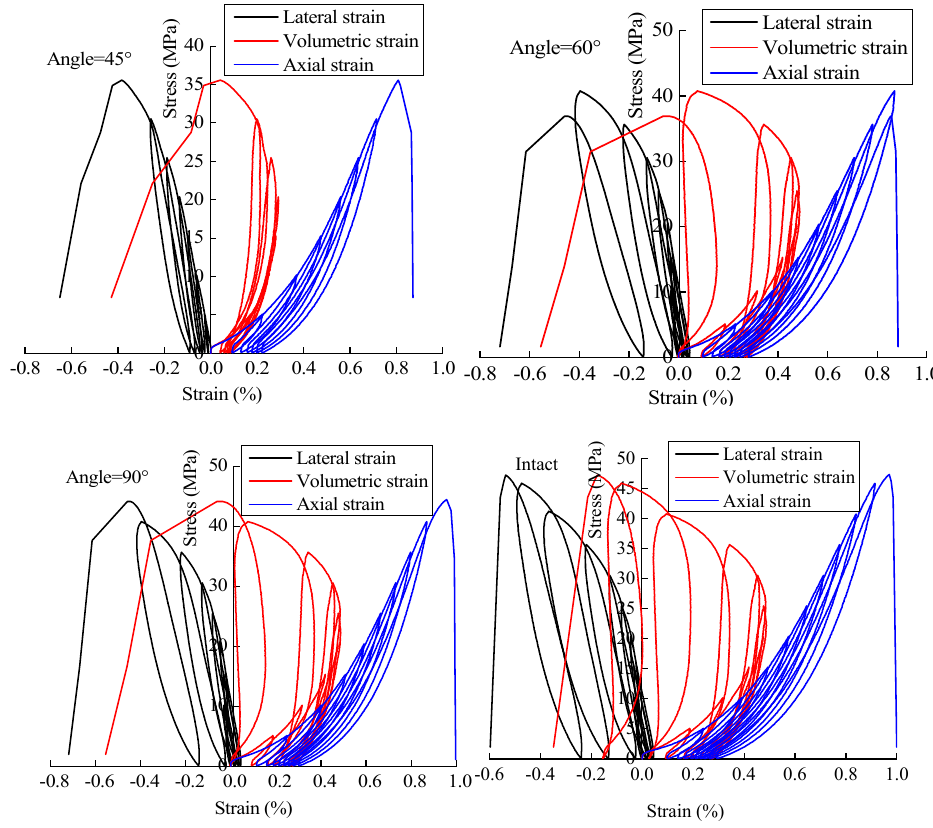
Figure 3. Stress-strain curves of specimens under cyclic loading. Table 1. Specimen styles and test results for group